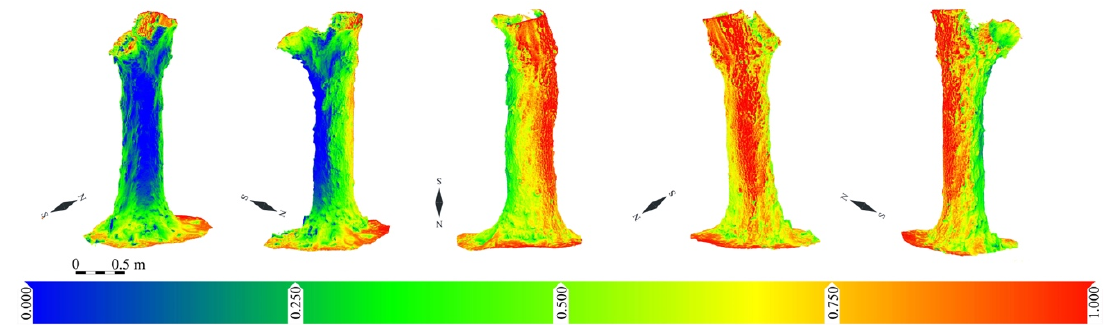
Figure 10. Different view of the reflectivity pattern of the CRP 3D model of the studied holm oak and represented in a 0–1 intensity color scale. The reflectivity is detected by the natural color radiometry of the tree. In this case, the lowest reflectivity is observed in the southern part of the tree (see blue areas in the figure).